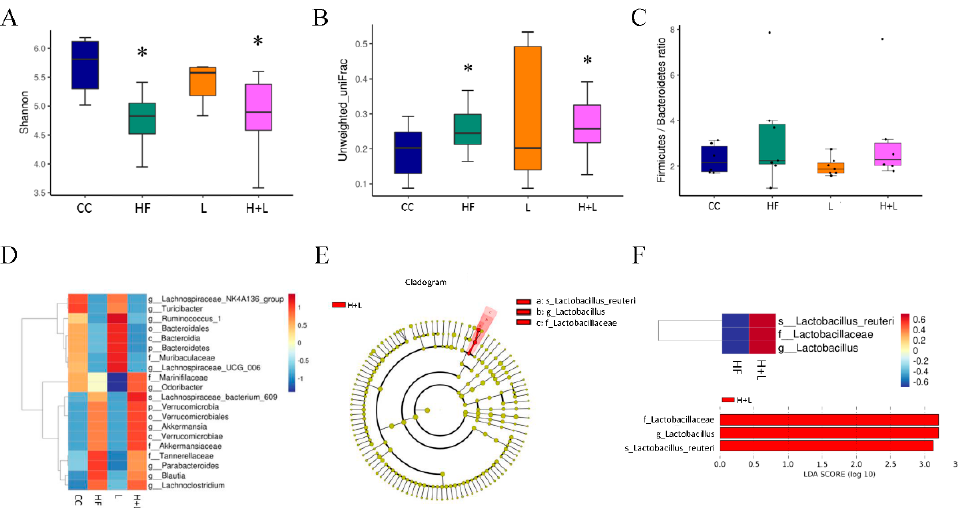
Figure 8. The effects of a high-fat diet and L. reuteri treatment during pregnancy on the gut microbiome of dams. ( A ) α -diversity ( B ) β -diversity ( C ) Firmicutes/Bacteroidetes (F/B) ratio ( D ) Heat map showing the relative abundance of microbiomes among the four groups. ( E ) Cladogram indicated that L. reuteri was the predominant bacteria in the HF and H + L groups. ( F ) For the linear discriminant analysis (LDA) distribution histogram, taxa that reached a linear discriminant analysis score (log10) >3.0 are highlighted and labeled. LDA and effect size (LEfSe) also showed that only L. reuteri increased in the H + L group compared to the HF group. * compared to the CC group, p < 0.05. CC, maternal control diet group; HF, maternal high-fat diet group; L, maternal control diet with prenatal L. reuteri treatment; H + L, maternal high-fat diet with prenatal L. reuteri